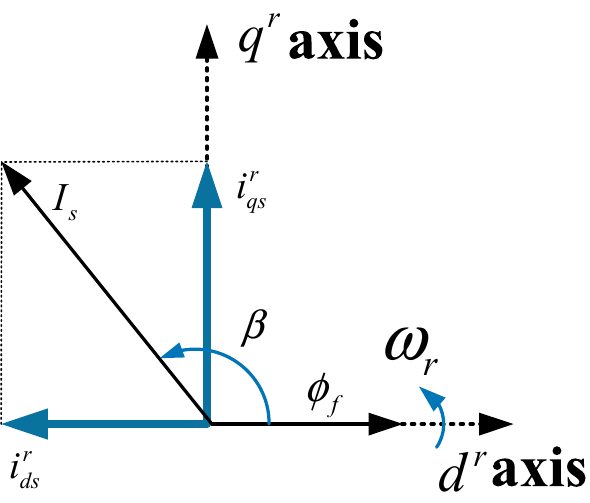
Figure 4. Relation of i r